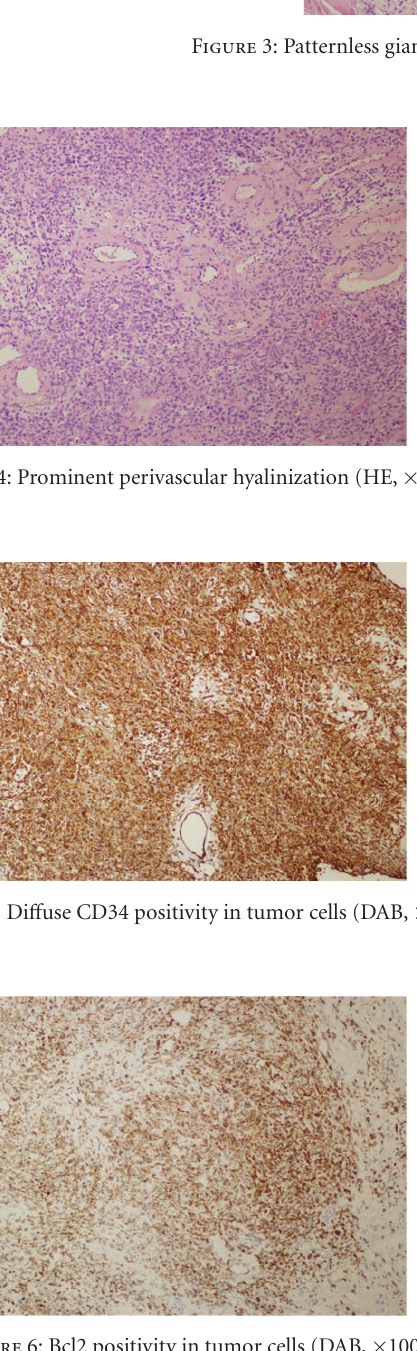
Figure 6: Bcl2 positivity in tumor cells (DAB, ×